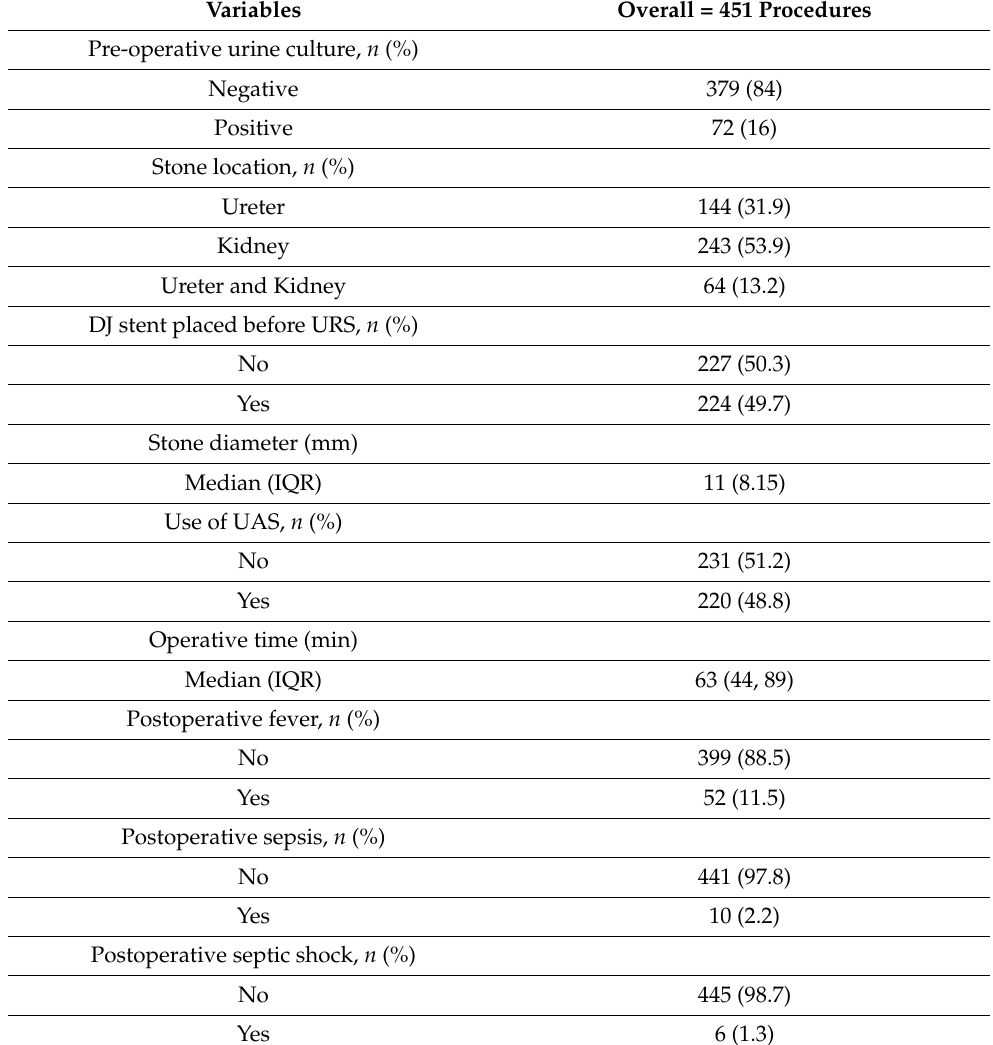
Table 2. Perioperative and surgical data of the 451 consecutive URS procedures. All values are shown as median (interquartile range) or frequency